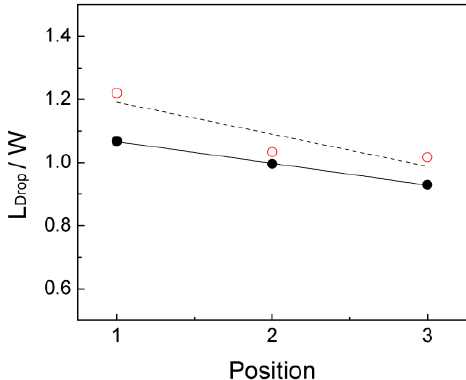
Figure 10. Dimensionless scCO 2 drop length (L drop,x /W) comparison between simulation results (open circles) at t = 2.5 ms, 18.235 ms, and 37.235 ms in Case 6 and experimental results (solid circles) at Q CO2 /Q H2O = 50/280 [19] when scCO 2 drop has a total flow time of 40ms in the straight channel.